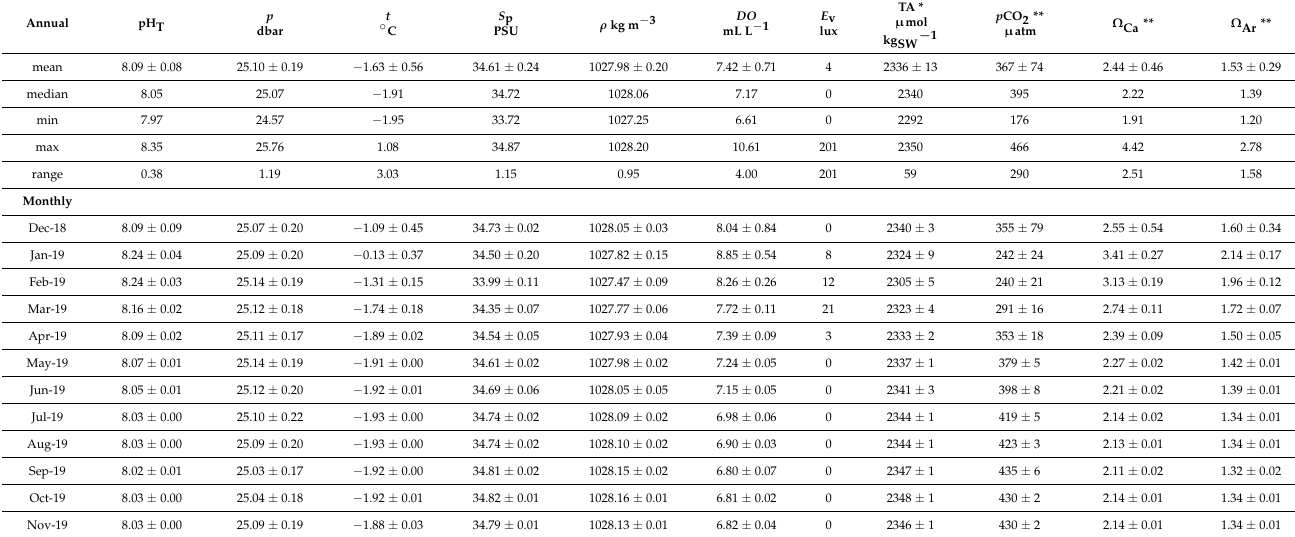
Table 2. Mean annual and monthly values, with their associated standard deviation (s.d.) (i.e., the measure of dispersion of the values over time), of total scale pH (pH T ), temperature ( t ), practical salinity ( S P ), density ( ρ ), dissolved oxygen ( DO ), illuminance ( E V ), total alkalinity (TA), p CO 2 , Ω Ca , and Ω Ar at the study site between November 2018 and November 2019. Values indicated by * were calculated from temperature and salinity measures [42] and ** were calculated using CO2Calc, K1 and K2 dissociation constants estimated by [43], total boron from [44], and KHSO4 dissociation constant by